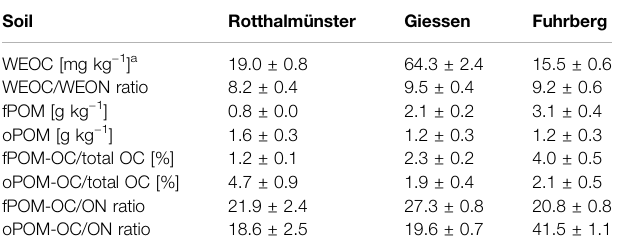
TABLE 2 | Content of water-extractable organic carbon (WEOC) and the WEOC/ WEON ratio as well as the content of free and occluded particulate organic matter(fPOM, oPOM),andtheir proportions intotalOCand theirOC/ONratios for soils used for incubation experiments. Soil